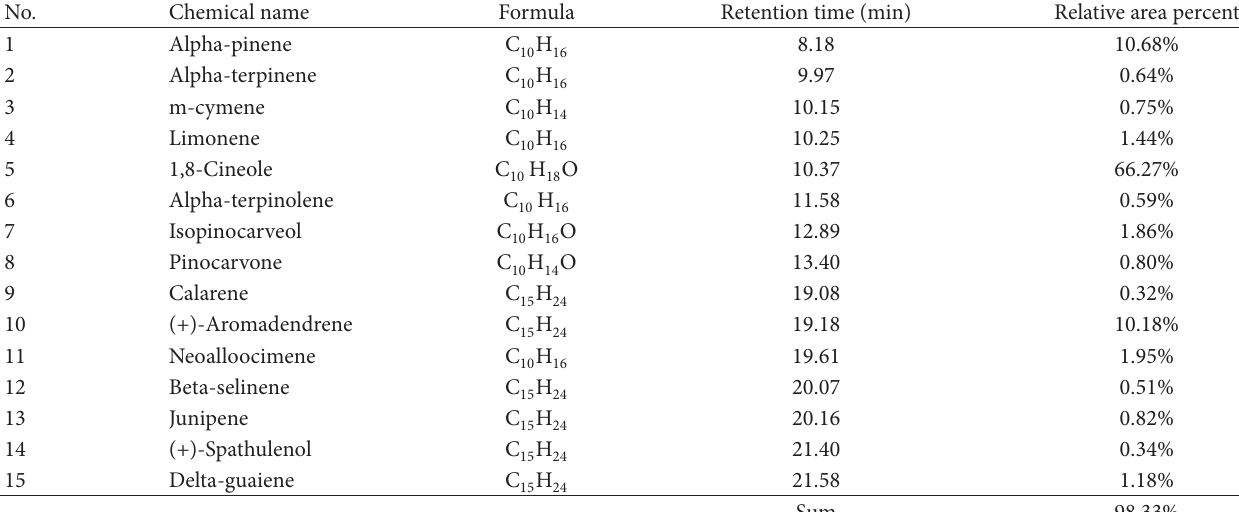
F 1: Schematic representation of substrate modi�cation and coating deposition procedure. T 1: Volatile organic compounds (VOCs) of Eucalyptus leaf extracted by